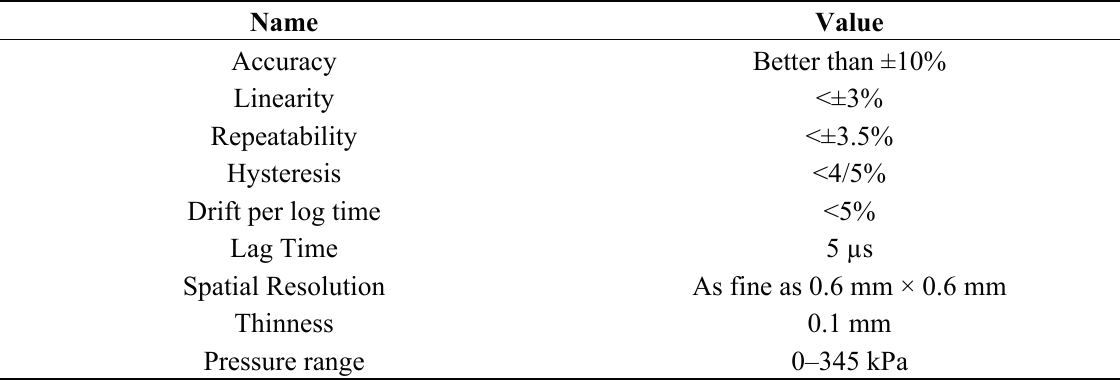
Table 1 Properties of the pressure